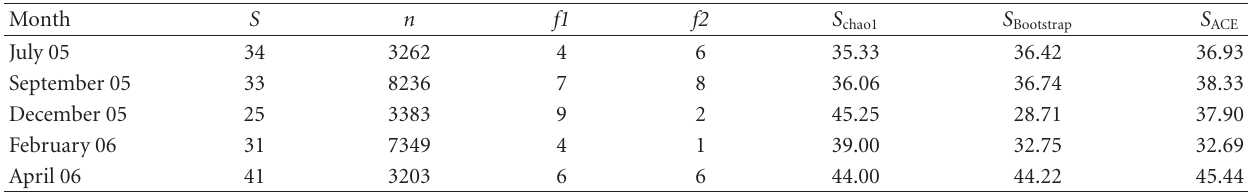
Table 3: Species richness estimates-temporal samples.